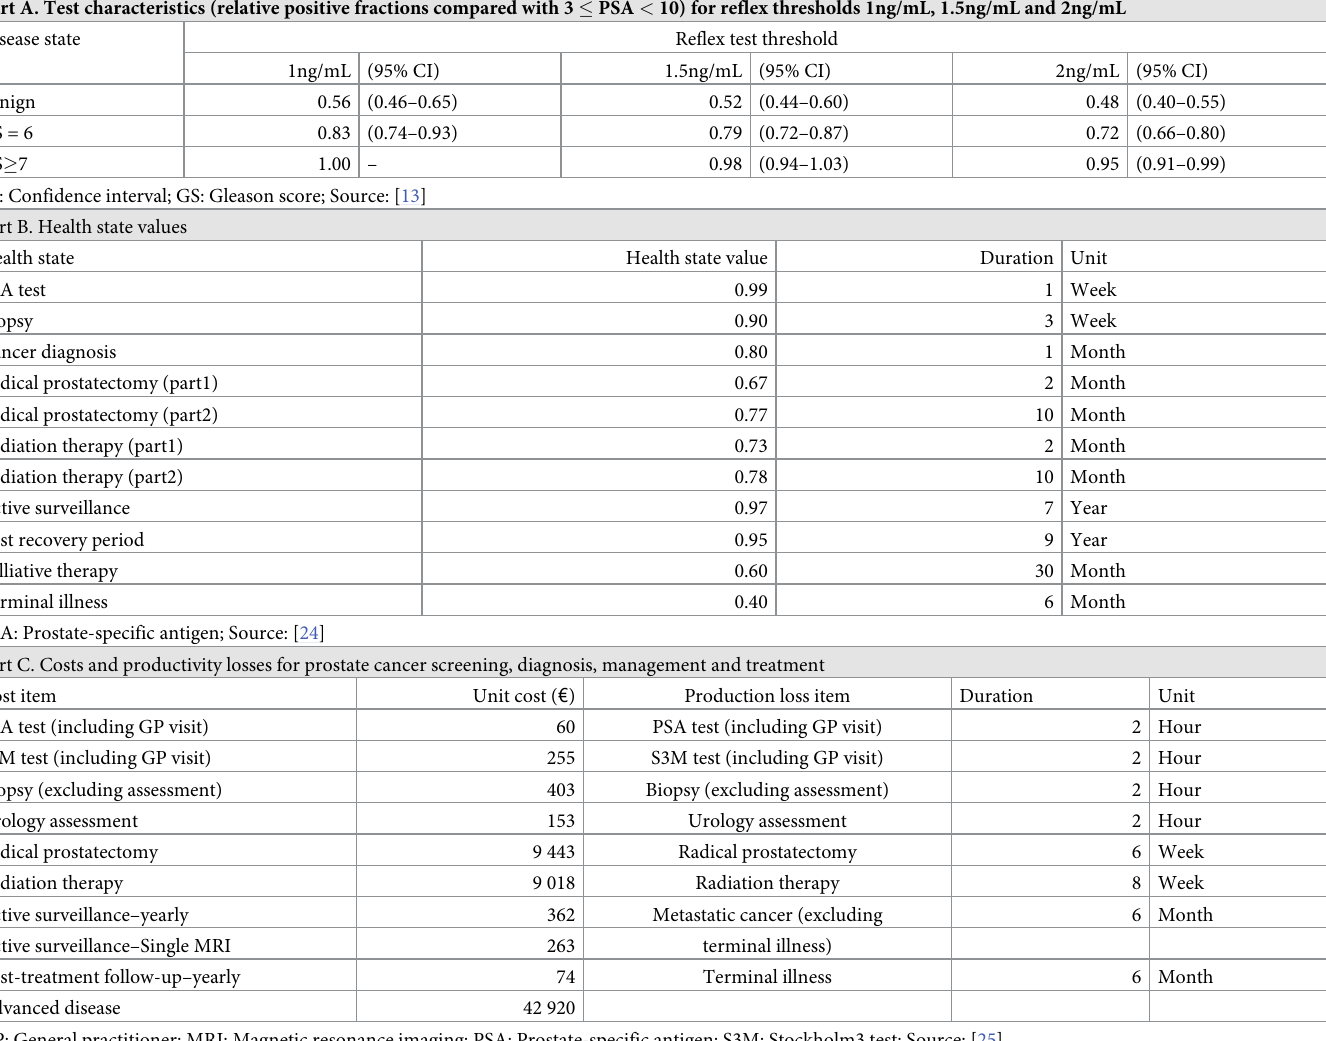
men for whom an S3M test was positive with PSA values between the reflex threshold and 10 ng/mL divided by the proportion with PSA 3–10 ng/mL. The three health or disease states, represented by D , included no cancer, Gleason score 6 cancers and Gleason � 7 cancers. The S3M reflex threshold was represented by α . The relative positive fraction r ( α | D ) for a threshold α for a given state D was defined as [22] r ð a j D Þ ¼ These relative positive fractions generalised the relative true- and false-positive fractions for three health or disease states. Values for r ( α | D ) were estimated from the Stockholm3 trial (see Table 1 Part A). Test characteristics for a reflex threshold of 1 ng/mL were described in [13]. For example, r ( α = 1| D = (Gleason � 7)) = 1 for S3M having the same sensitivity as PSA for Table 1. Input